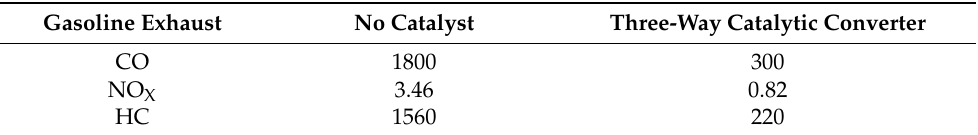
Table 6. The emissions (mg/km) of CO, NOX and HC in a gasoline exhaust from vehicles without catalysts and a TWC. Adapted from